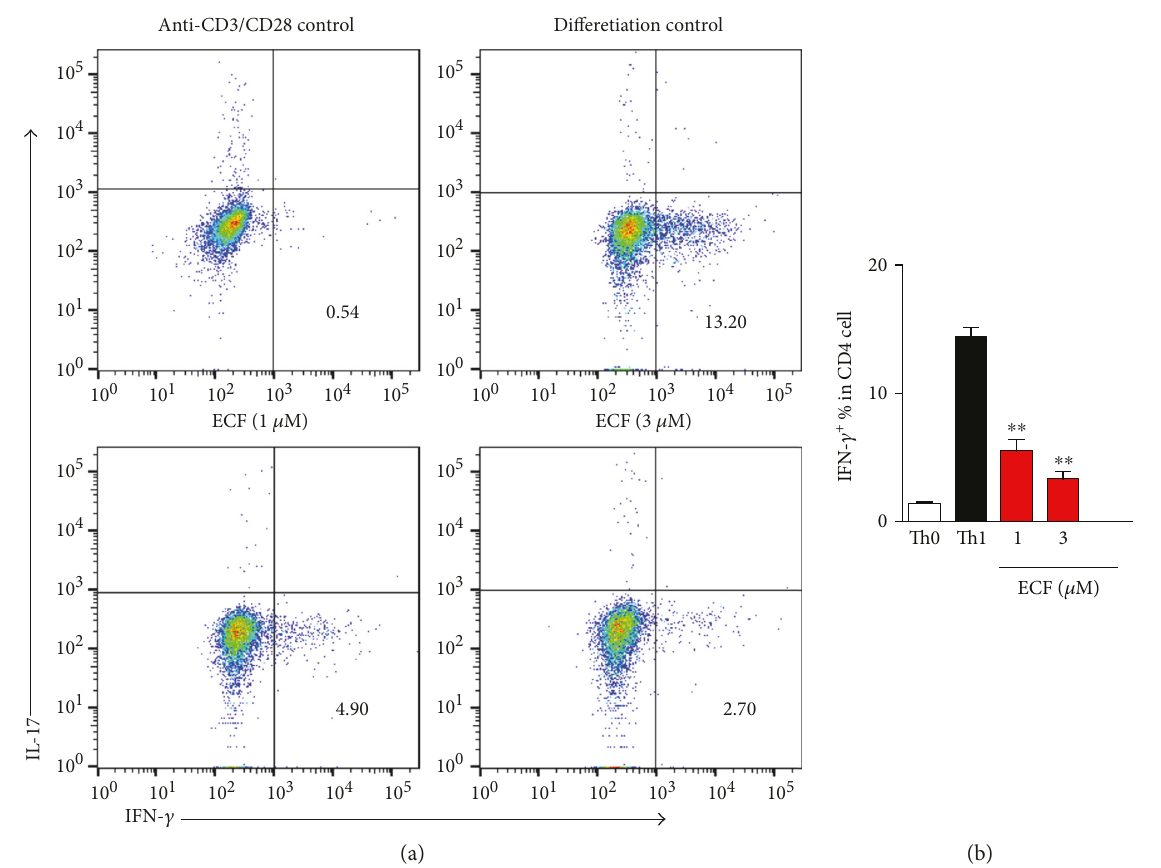
Figure 6: ECF inhibits Th1 cell di ff erentiation. Naive CD4 T cells (4 × 10 5 ) in 24-well plates precoated with anti-CD3 and anti-CD28 were cultured in RPMI containing 10% FCS and polarizing cytokines at various concentrations of ECF. The di ff erentiated cells were harvested after 3 days and were restimulated for 4h with PMA and ionomycin in the presence or absence of Brefeldin A for fl ow cytometry. Data were analyzed by FlowJo